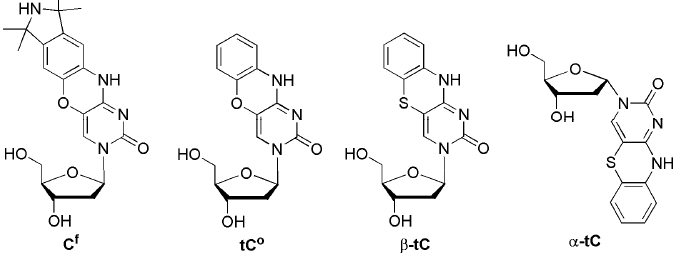
Figure 8. Tricyclic cytidine analogs, C f , tC o , β -tc , and α –tc .